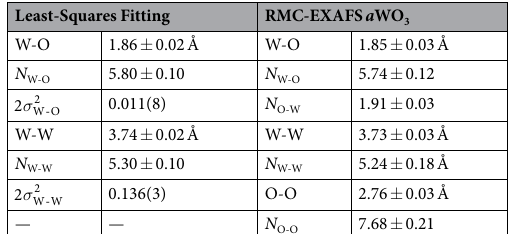
Table 1. Main interatomic bond-distances, atomic coordination and 2 σ 2 factors of a WO 3 calculated from nonlinear least-squares fitting of the experimental χ k k ( ) 3 and FT χ k k ( ) 3 spectra to single- and multiple- scattering theory [ ≈ .